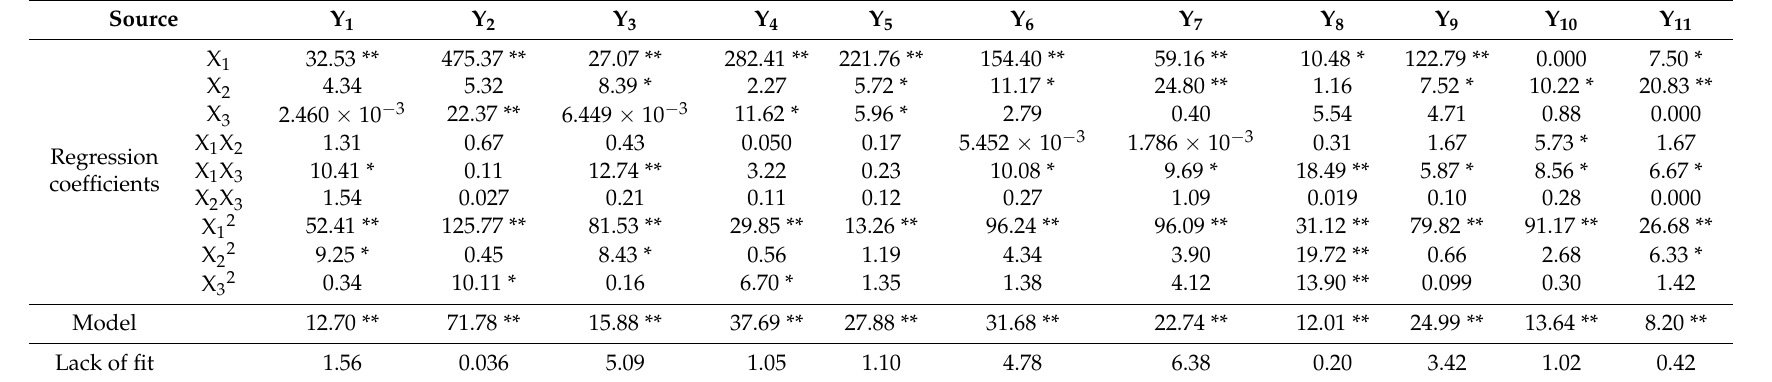
Table 3. F -test values of regression coefficients, model and lack of fit for Y 1 –Y 11